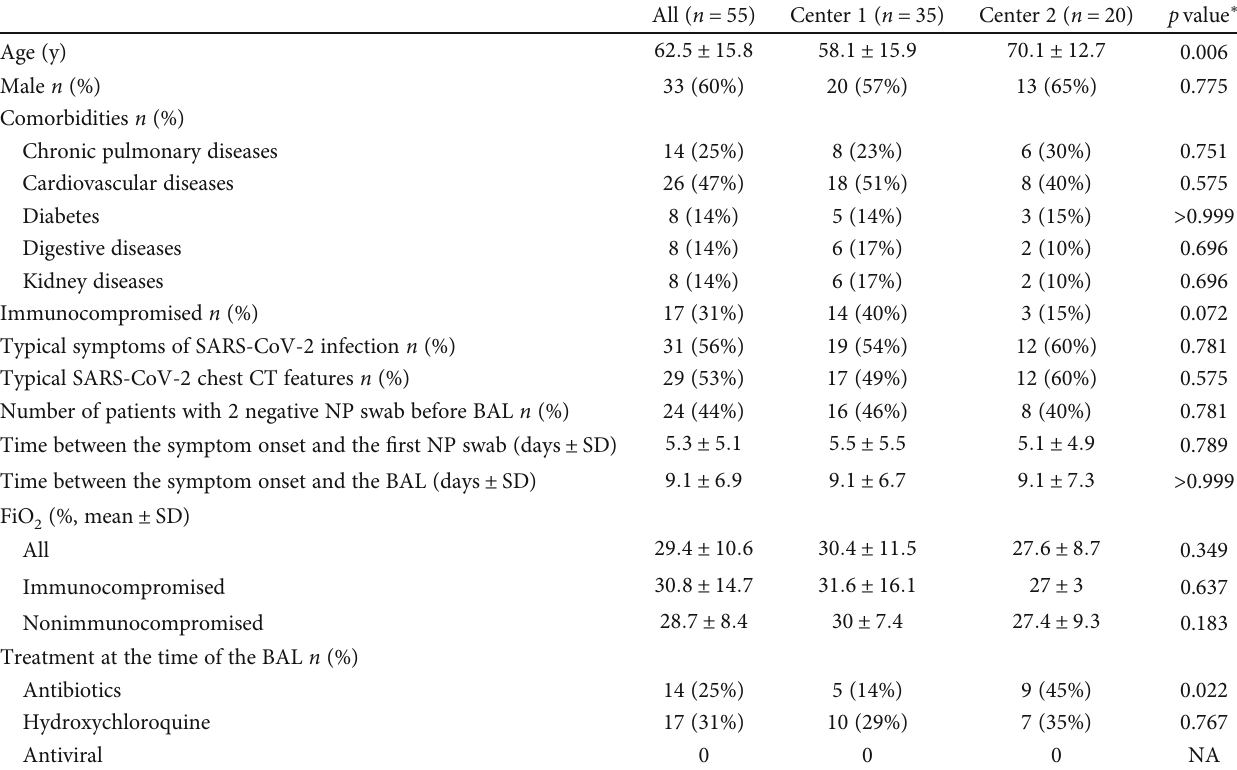
Table 1: Demographic and baseline characteristics. Typical symptoms of SARS-CoV-2 infection correspond to the presence of more than one of the following signs or symptoms: fever, cough, dyspnea, hypoxemia, or fl u-like syndrome. Typical chest CT scan features of a SARS-CoV-2 infection include the presence of peripheral bilateral ground glass opacities with or without consolidations and intralobular septa thickening.